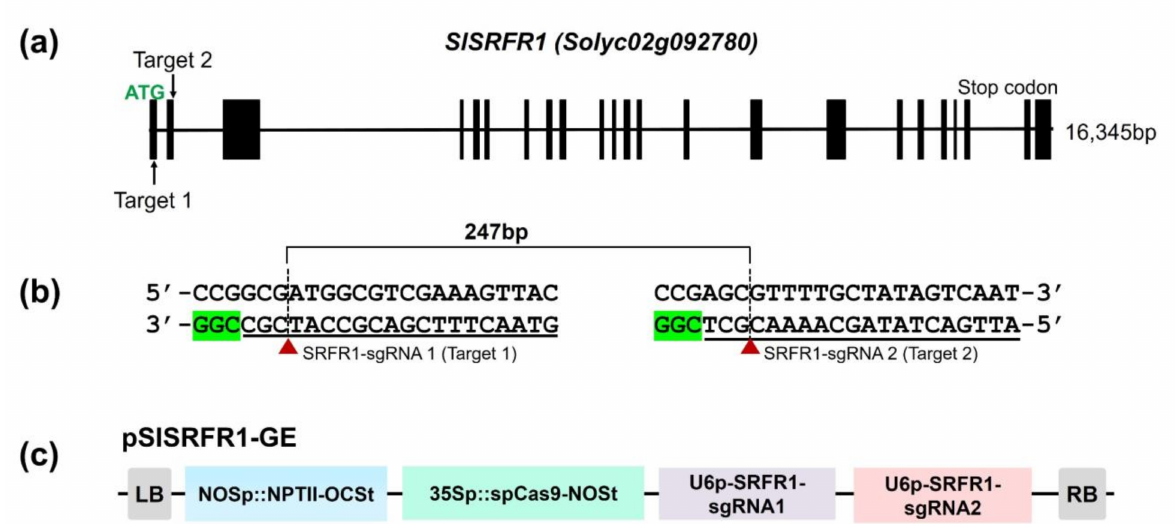
Figure 3. Tomato SRFR1 gene structure and vector construction for CRISPR/Cas9-mediated genome editing in SlSRFR1 . ( a ) Predicted SlSRFR1 gene structure and the position of guide RNAs in SlSRFR1 . The black box denotes exon, and the line means intron. Two guide RNAs are indicated with an arrow in the first and the second exons, respectively; ( b ) target sequences of sgRNAs. Predicted cut sites by CRISPR/Cas9 are denoted with red triangles and dotted lines; ( c ) construction of CRISPR/Cas9-mediated genome editing for SRFR1 in tomato. NPTII was used for a plant selection marker. Two guide RNAs were expressed by AtU6 promoter and terminated by poly